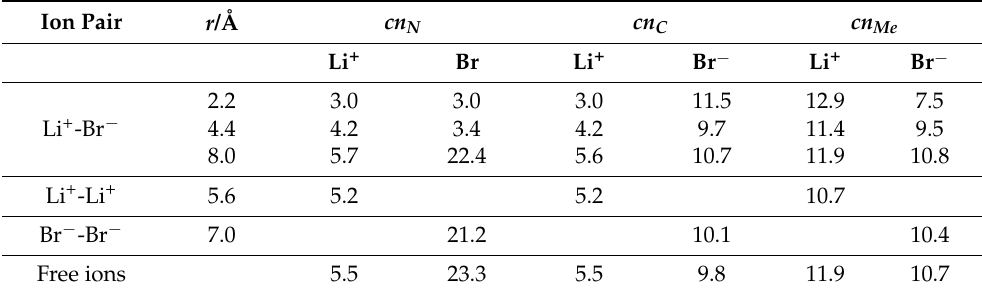
Table 8. Ion–solvent coordination numbers for each ion pair and interionic separation.